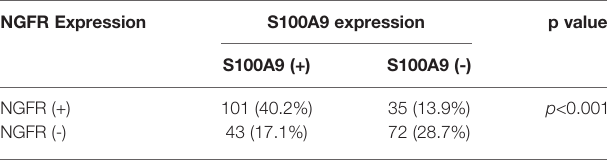
TABLE 1 | Correlation between NGFR and S100A9 protein expression. NGFR Expression